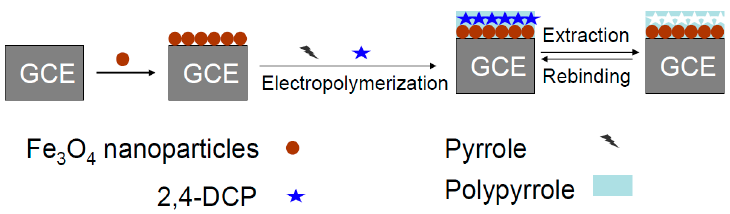
Figure 1. The procedure for the preparation of molecularly imprinted polymers modified glassy carbon electrode (MIPs/Fe 3 O 4 /GCE).